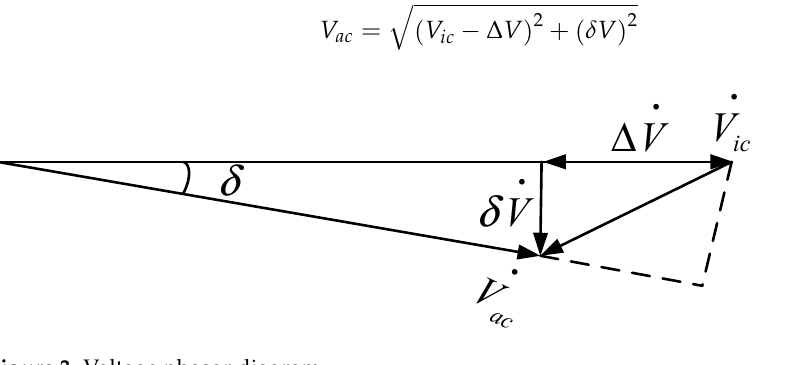
Figure 3. Voltage phasor diagram.